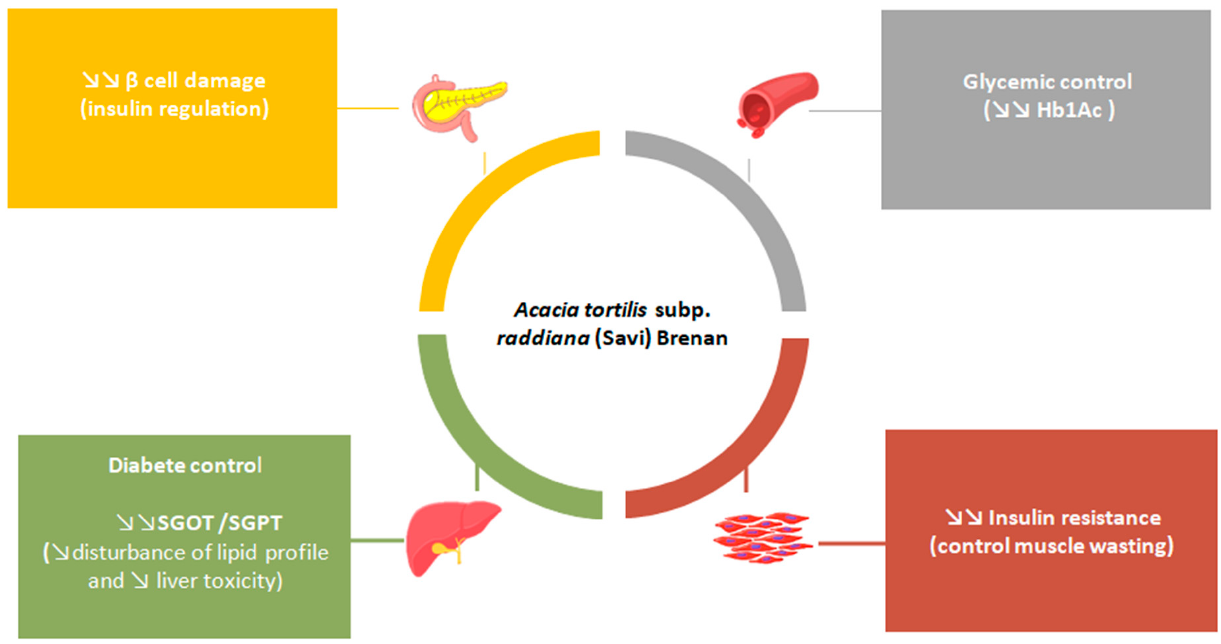
Figure 6. In vivo antidiabetic mechanism effects of V. tortilis.